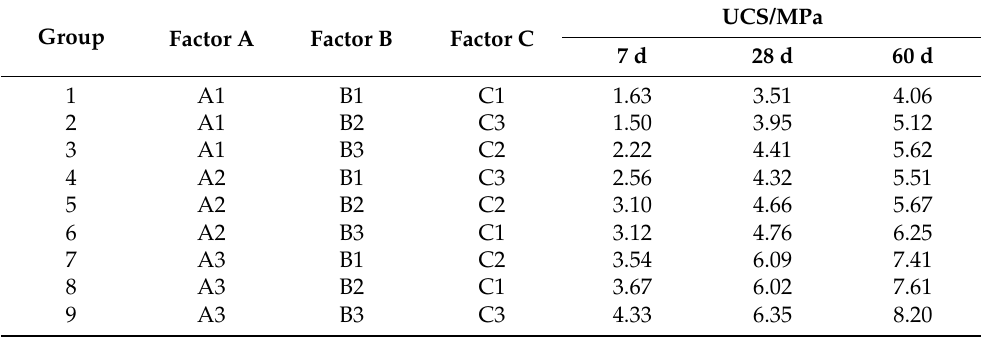
Table 6. UCS of the FA-WG-composite-cemented soil (MPa).